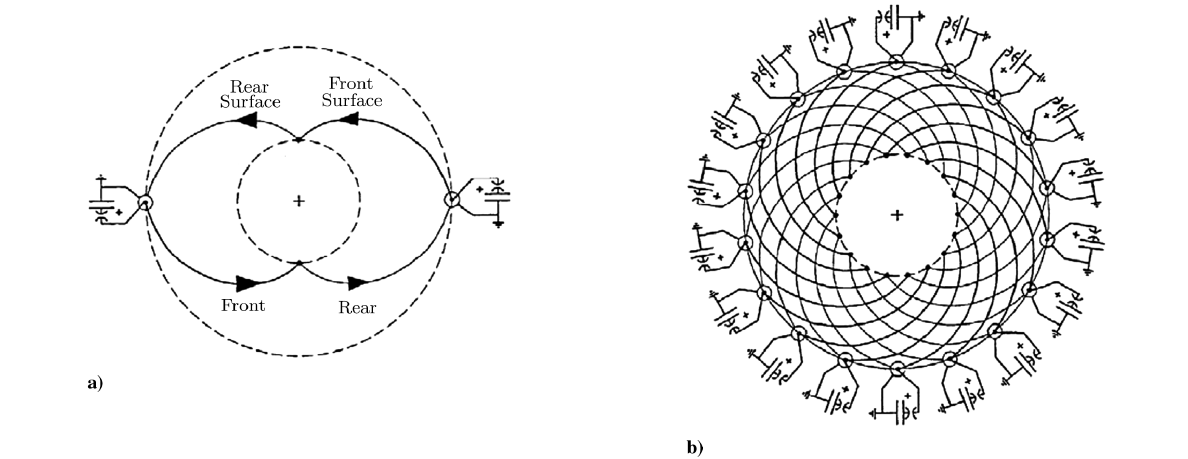
Figure 2. PIT MK V and MK Va Marx-generator coil configuration: ( a ) one complete Marx-generator loop and ( b ) the nine complete loops comprising the entire coil (from